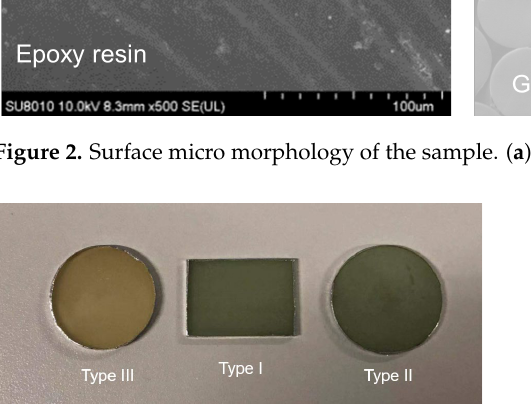
Figure 3. The appearance of the three types of samples.